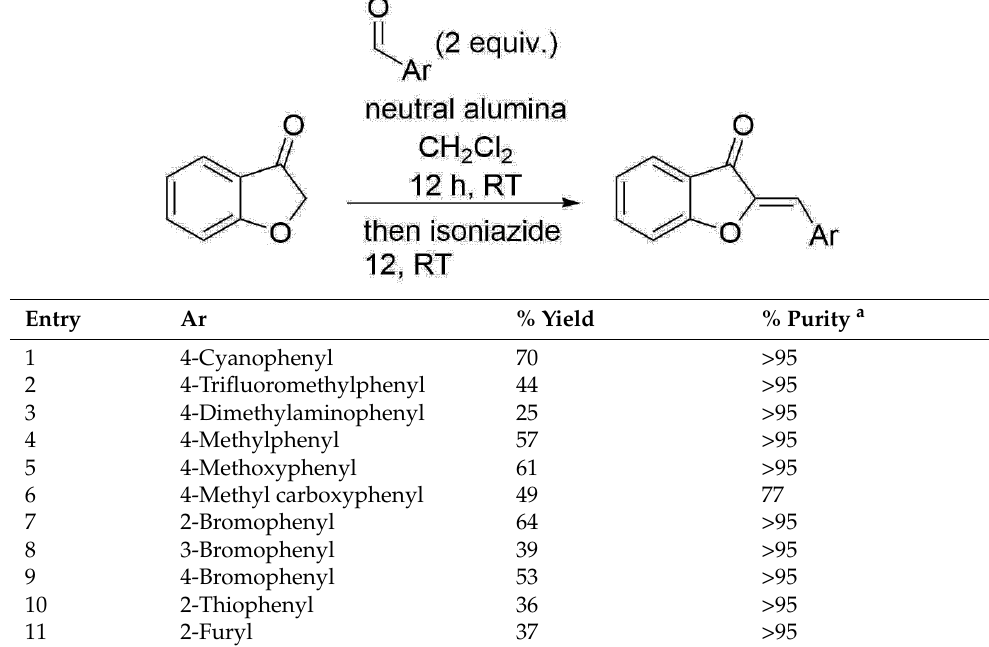
Table 2. Variations in aldehyde using isoniazid as the scavenger.